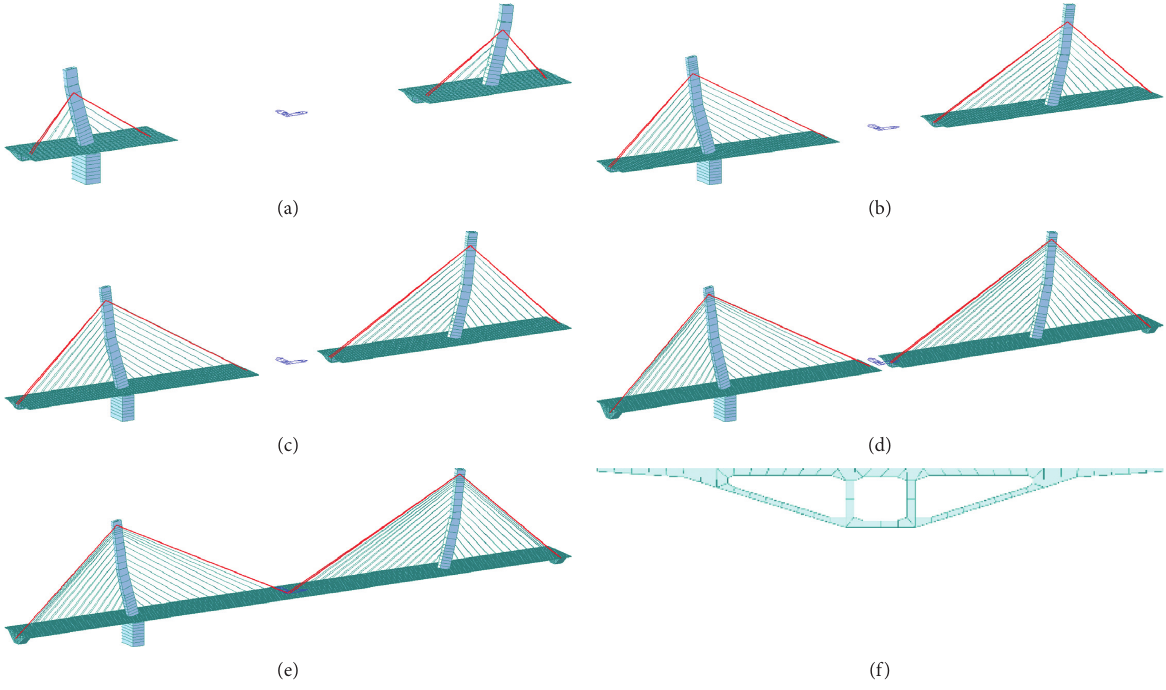
Figure 6: Special finite element model for main construction operating conditions. (a) Tension C4 (C4 ′ ), applying a basket load. (b) Tension C10 (C10 ′ ), applying a basket load. (c) Cable tension adjustment, tensioning C11(C11 ′ ), applying a hanging basket load. (d) Tension C14(C14 ′ ), applying a hanging basket load. (e) Tension C15 (C15 ′ ), applying counterweight, midspan closure. (f) Grid division of main beam